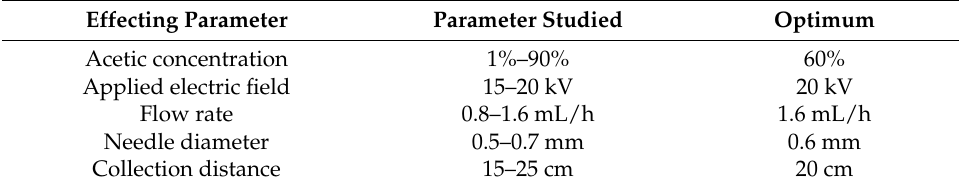
Table 1. Electrospinning conditions for fabrication of